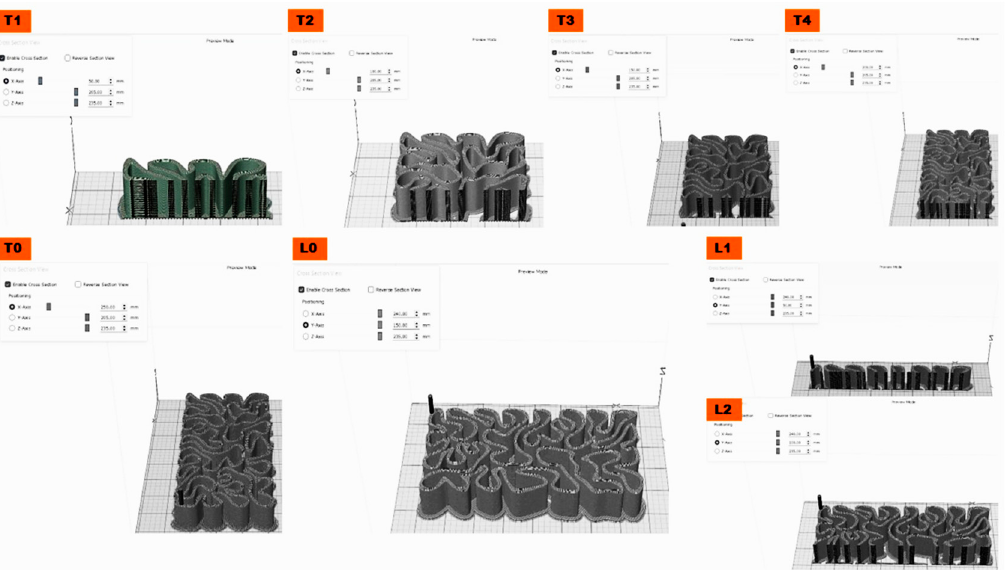
Figure 5. Shows one linear brick model of the V2 family of the 3D-printed biodigital clay bricks showing the nonuniform cross sections along both axes (longitudinal and transversal) and conse- quently the numerous collective cross sections that each brick of the biodigital bricks has. T0 and L0 represent the two axial views of the V2 linear model full brick (T: transversal, L: longitudinal); from T1 to T4 shows the various transversal cross sections of the V2 linear model brick that were captured every 50 mm along the axis; L1 and L2 are the two longitudinal sections captured every 50 mm along the Y -axis—showing the nonuniform morphogenic forms of the biodigital clay